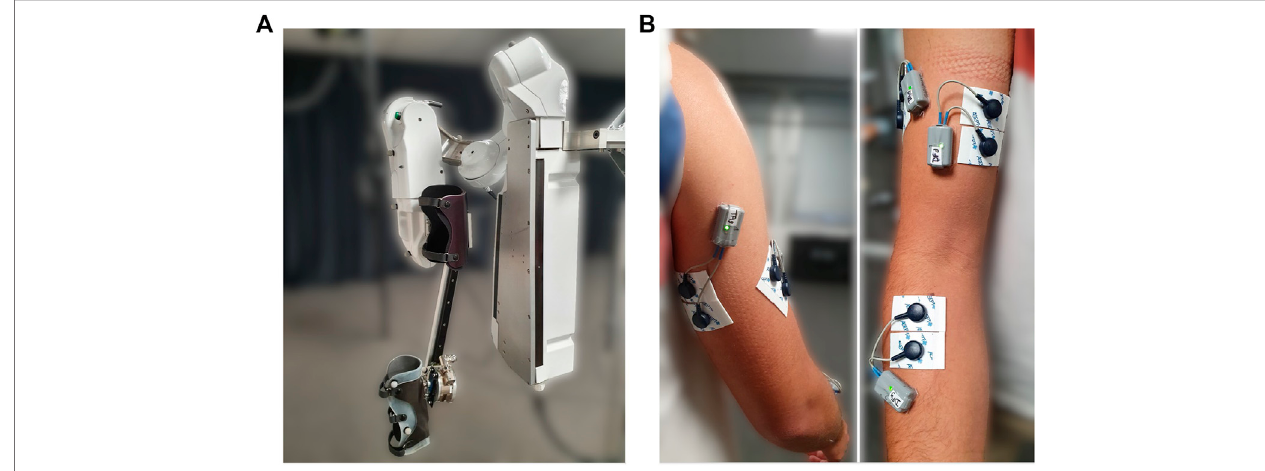
FIGURE 5 | Material and experimental set-up. (A) ABLE exoskeleton used in the present study. (B) Disposition of EMG sensors (back on left, front on right).